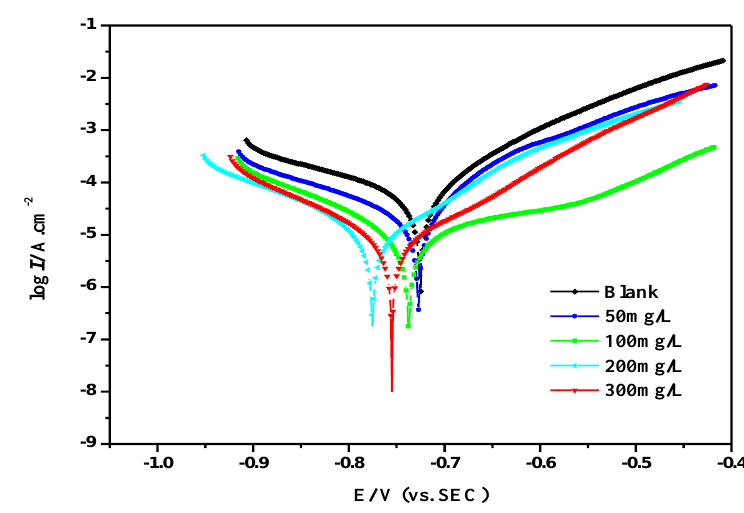
Figure 5. Tafel curve of N80 steel with different concentrations of MBT.